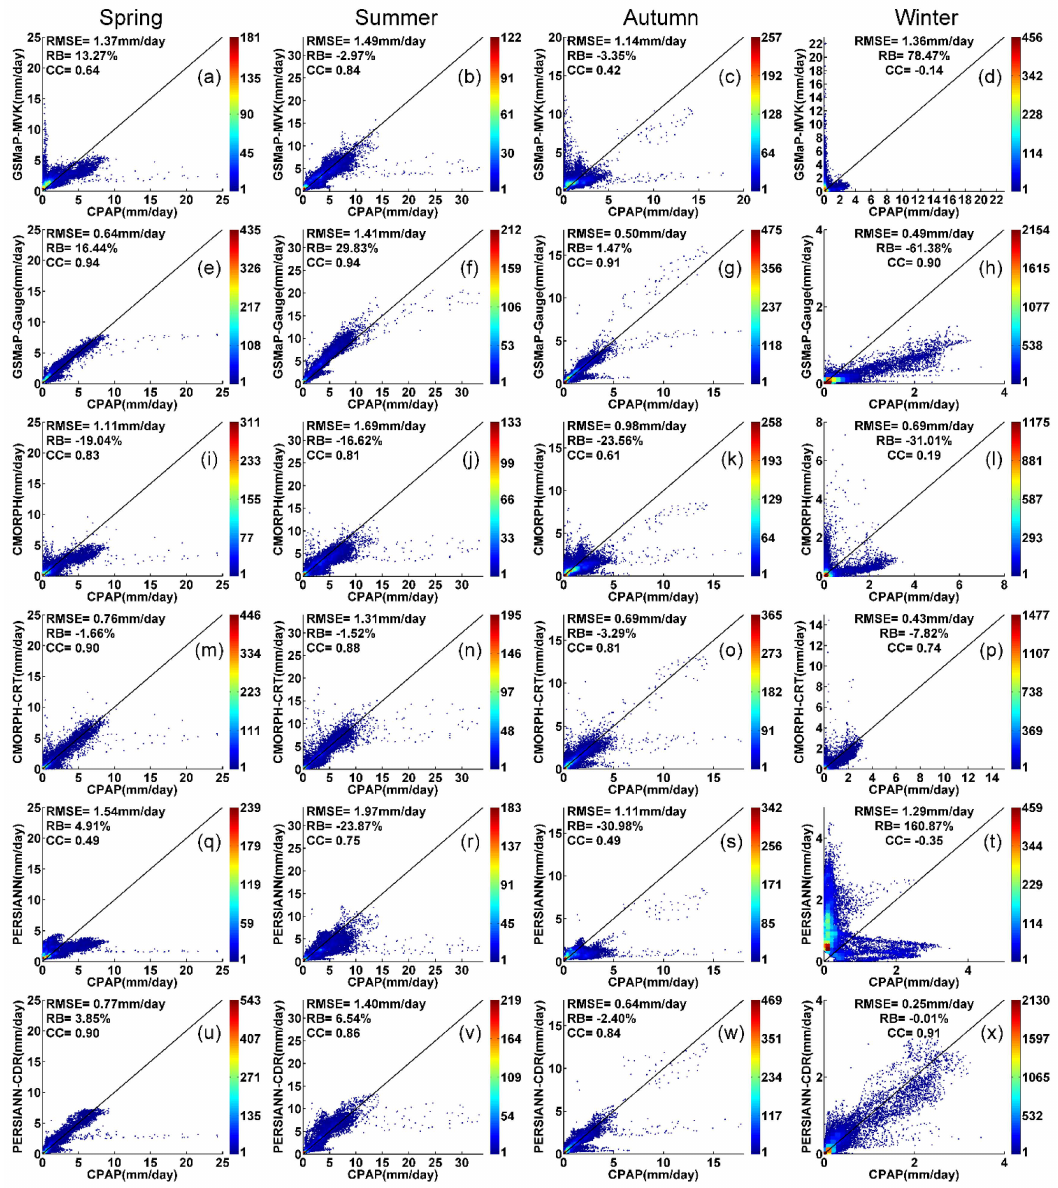
Figure 6. Density-colored scatterplots of ( a – d ) GSMaP_MVK; ( e – h ) GSMaP_Gauge; ( i – l ) CMORPH; Figure 5. The color represents the occurrence